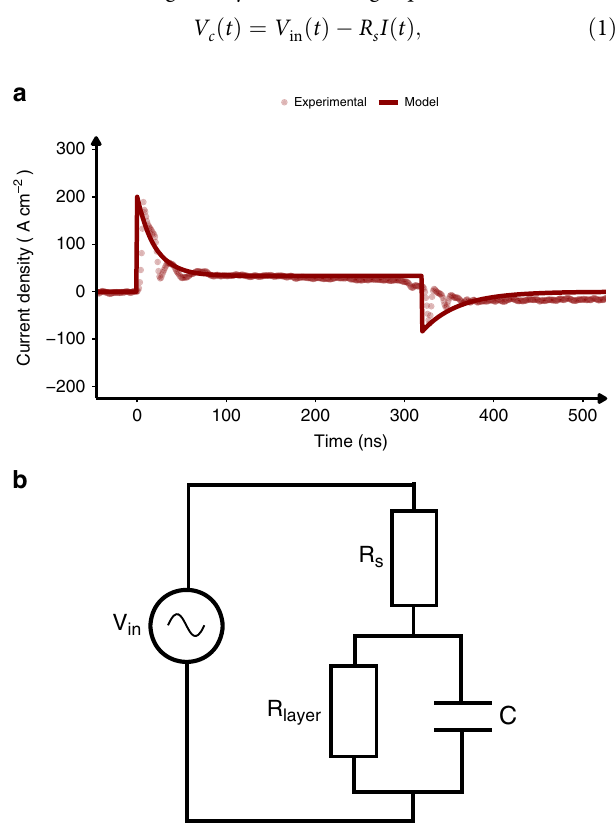
Fig. 1 Electrical circuit model and current response of OLED. Typical current density curve of Super Yellow OLED depicting rapid current spike and subsequent relaxation to steady state followed by negative spike at turn-off for. The OLED was excited with 300-ns voltage pulse. Fig. 1b shows equivalent circuit used for OLED modelling consisting of layer resistance ( R layer ), series resistance ( R s ), and capacitor ( C